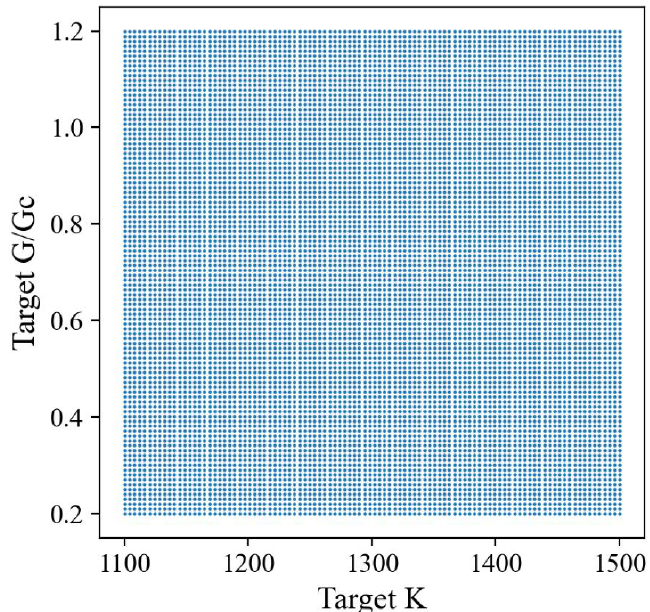
Figure 9. Scatter plot of target properties of stiffness and toughness. The unit of K is N/m.